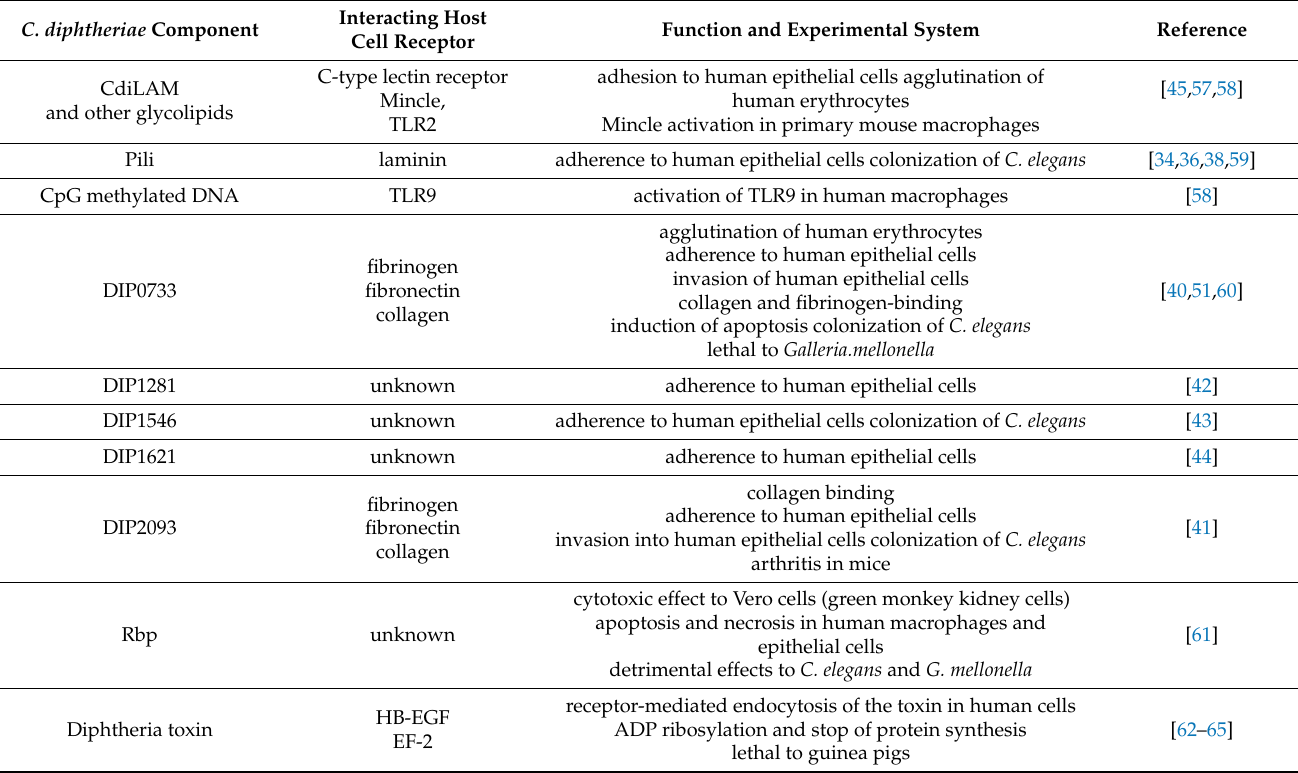
Table 2. C. diphtheriae virulence factors and their putative human and murine